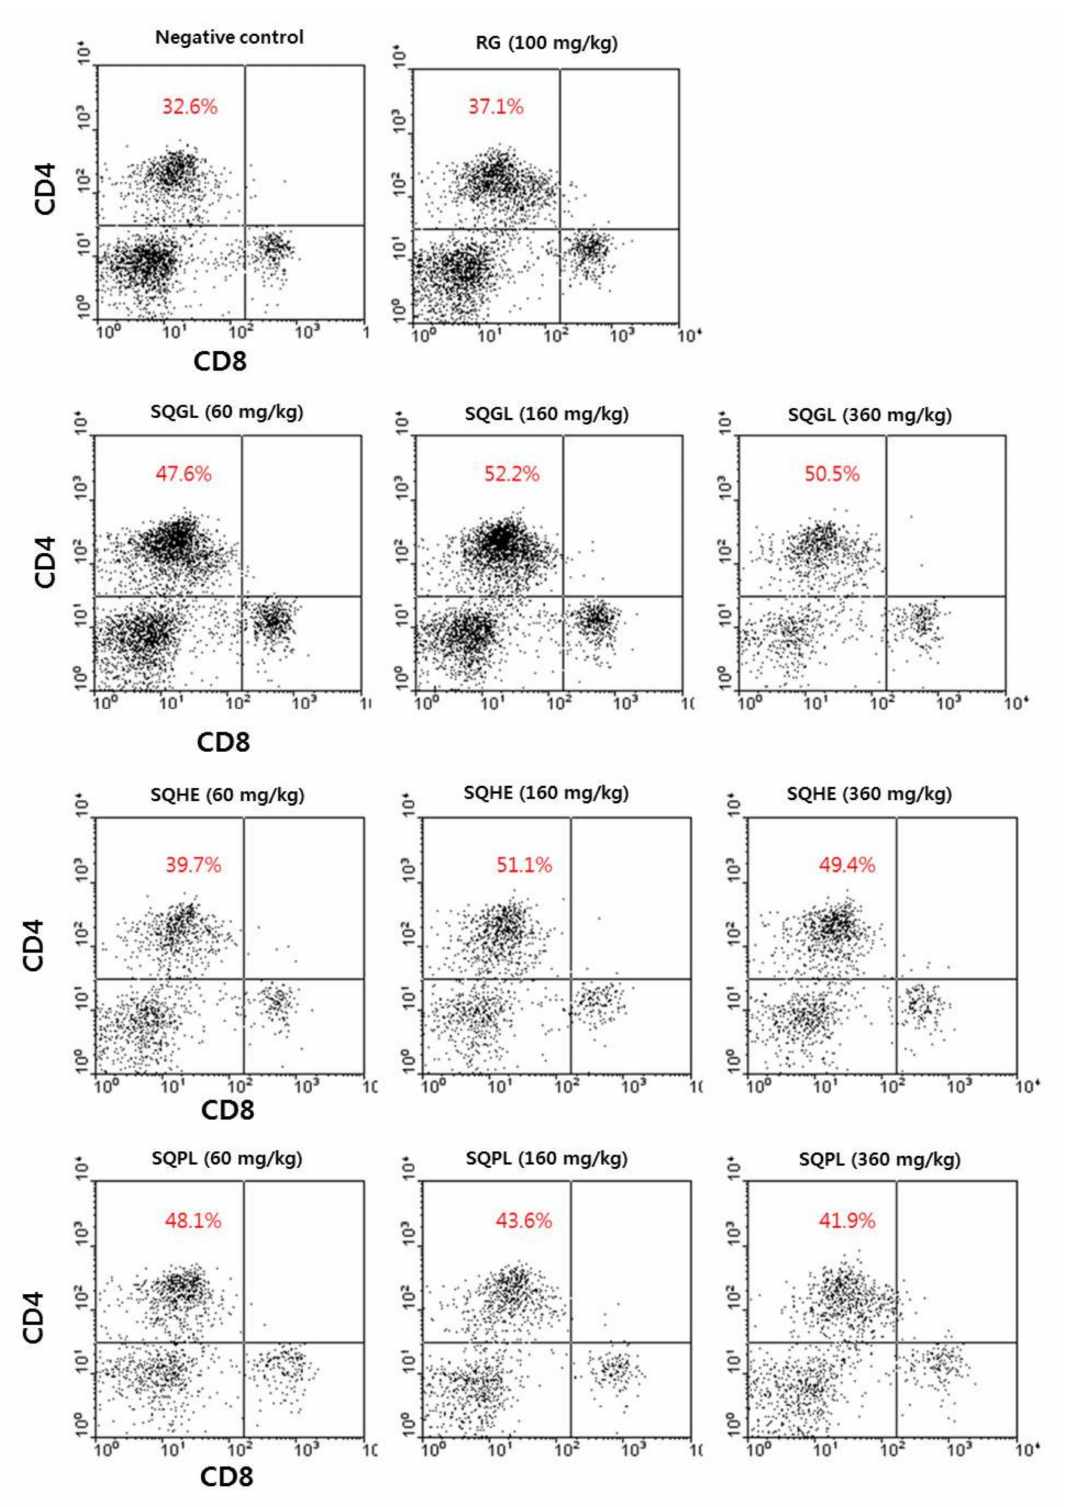
Figure 1. Changes of Th cell population in PBMC in the mice administered S. quelpaertensis leaves fermentation products for two weeks. RG, red ginseng; SQGL, S. quelpaertensis leaves fermentation product by G. lucidum ; SQHE, S. quelpaertensis leaves fermentation product by H. erinaceum ; SQPL, S. quelpaertensis leaves fermentation product by P. linteus